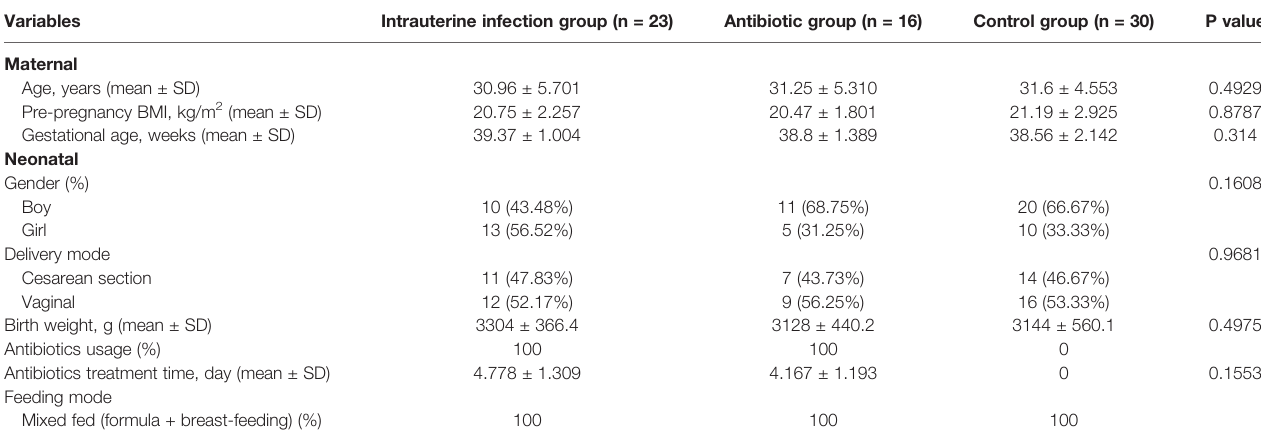
TABLE 1 | Clinical information for all mothers and